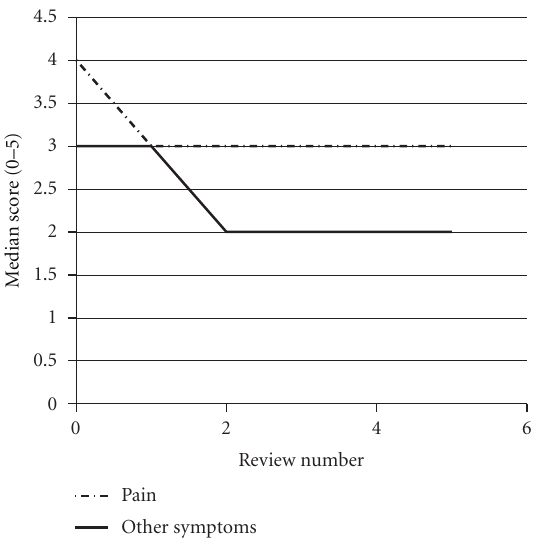
Figure 3: Changes in median APCA POS scores for pain and sym- ptom control over time using the APCA POS. This graph depicts the changes in median scores for questions 1 and 2 from baseline to review number 5.